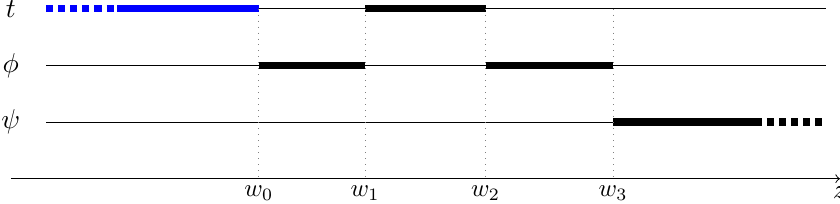
Figure 9 . Rod diagram for the black ring inside the bubble of nothing. A semi-infinite timelike rod for z < w 0 has been added to the ordinary black ring